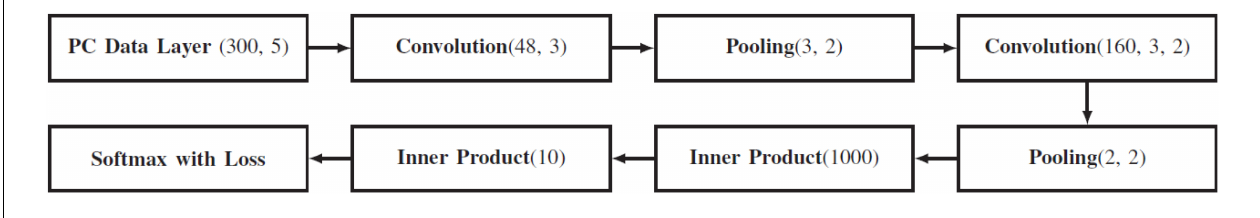
FIGURE 2 | Structure of